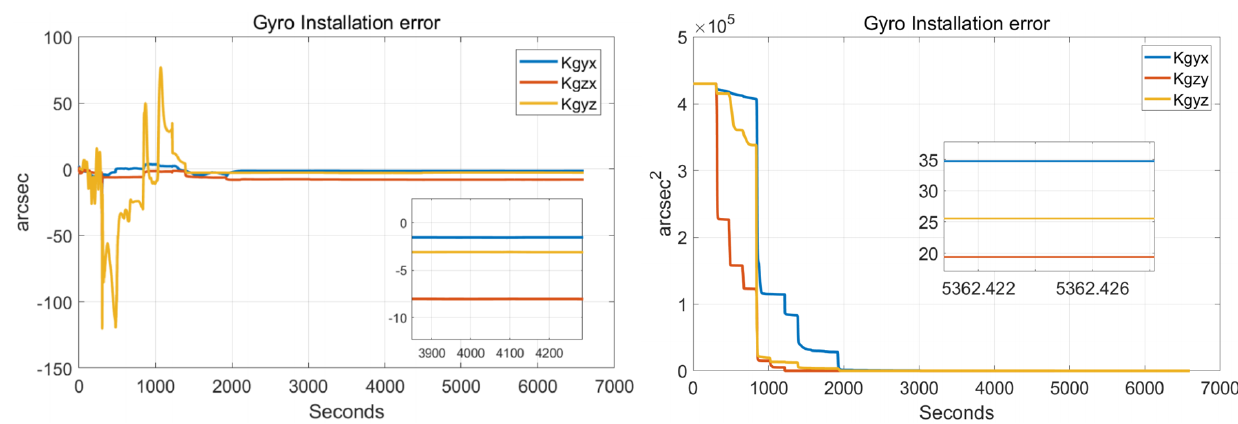
Figure 8. Gyro installation errors.